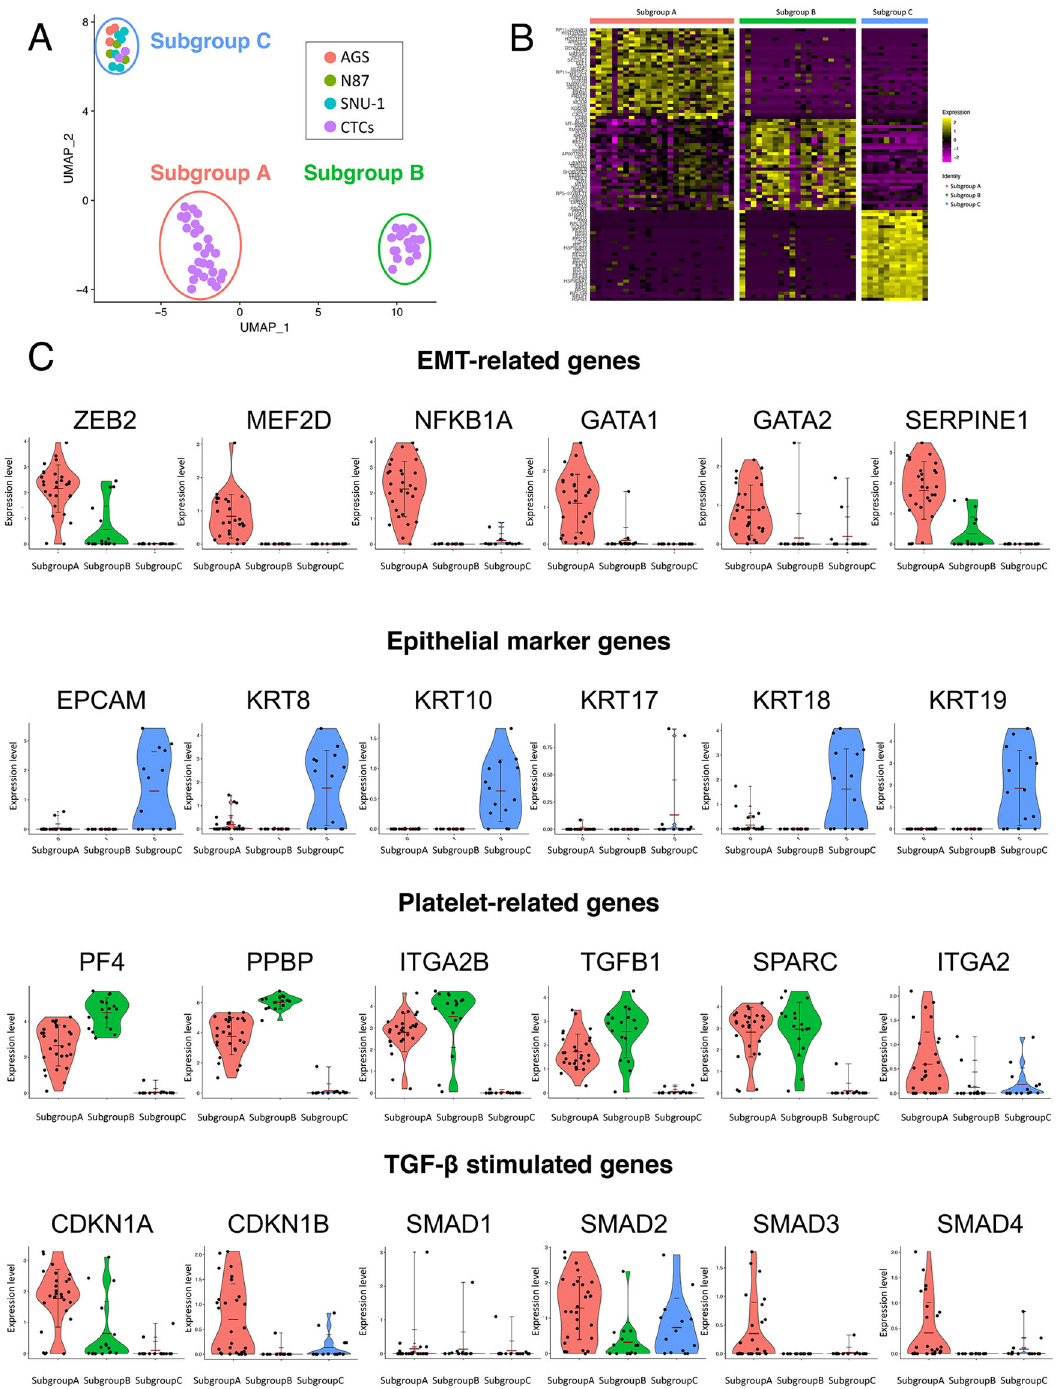
Fig. 4 Gene expression and clustering of gastric CTCs. A UMAP plot of single gastric cancer cells and gastric CTCs. (12 cancer cells and 47 CTCs from 21 patients. Each dot represents a single cell. Salmon pink: AGS, green: NCI-N87, blue: SNU-1, purple: gastric CTCs) ( B ) Heatmap of overexpressed genes of each subgroup. Top 30 overexpressed genes from each subgroup are shown. Heatmap showed log scaled RPM that increases from purple to yellow. C Violin plot for expression of EMT-related genes, epithelial genes, platelet related-genes, TGF- β stimulated genes. Each dot represents a single-cell. The red bar represents mean value. The black bar represents AGS (salmon pink), N87 (blue), and SNU1 (purple) indicates into multiple subtypes, and performed clustering by Seurat, a gastric cancer cell lines. Single cells were classi fi ed into three package for single-cell RNA-seq analysis, and extracted genes subgroups; most of the CTCs belonged to subgroups A and B. that characterize each cluster 49 . Figure 4A is a Uniform The cell lines and only two CTCs belonged to subgroup C. We Manifold Approximation and Projection (UMAP) plot that measured nCount and nFeature of CTCs to con fi rm that clus- illustrates the clustering of CTCs and cancer cell lines. Each dot tering analysis revealed biological differences. We con fi rmed indicates one cell, G (green) indicates gastric cancer CTCs, and